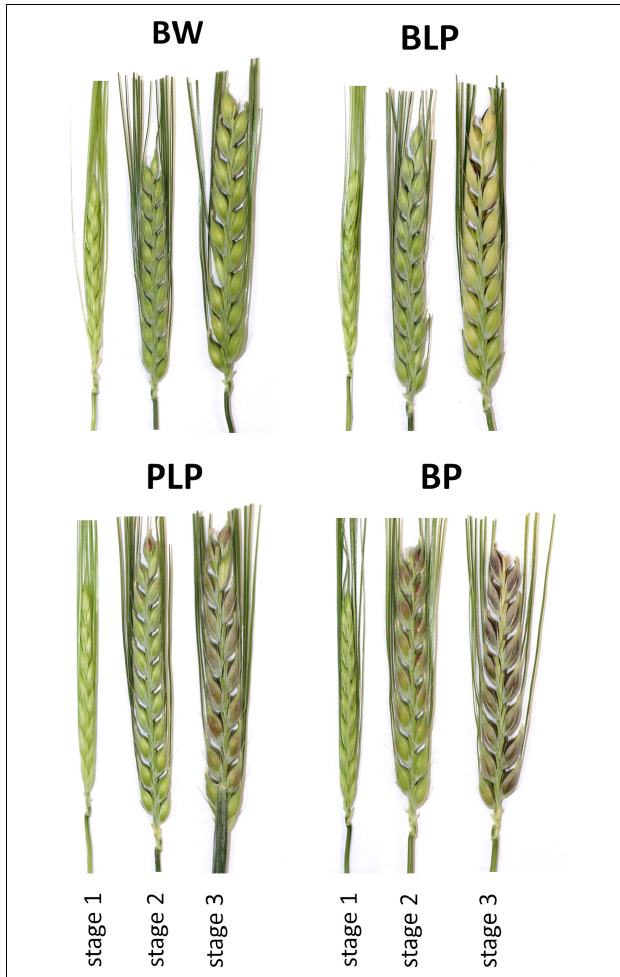
FIGURE 2 | Spikes of barley NILs BLP, PLP, BP, and of cv. Bowman (BW) used in the study at the booting stage (1), late milk stage (2), and early dough stage